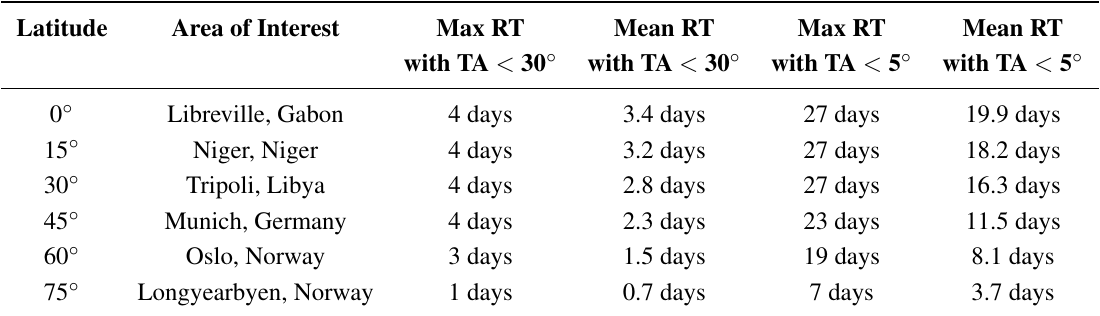
Table 2. Maximum and mean revisit time (RT) in descending orbits for six different latitudes, represented by areas of interest, and two maximum across track tilt angles